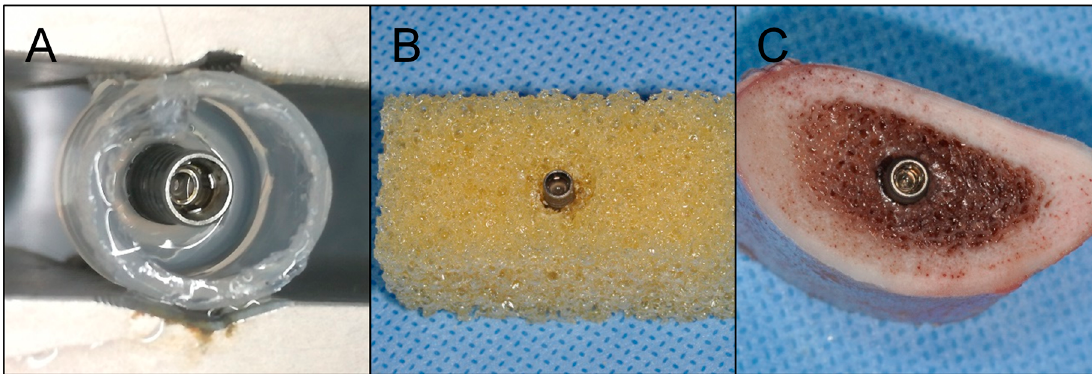
Figure 3. Placement of dental implants in model substrates. ( A ) Silicone simulating periimplant soft tissue, ( B ) polyurethane foam mimicking type IV alveolar bone with a circumferential defect and ( C ) bovine ribs.